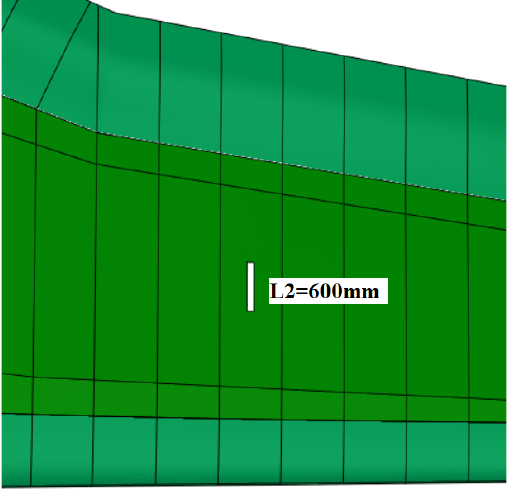
Figure 7. Illustration of the damage cutting through three stringer components.